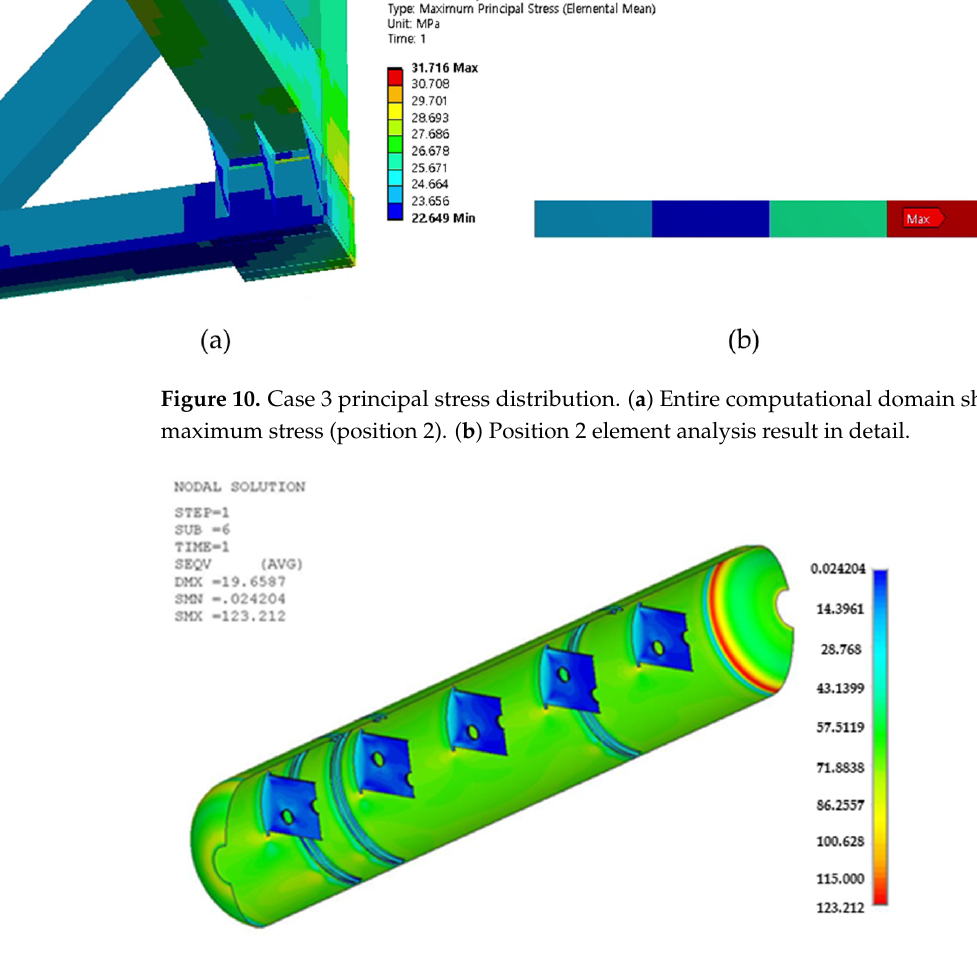
Figure 11. Case 4 principal stress contour map distribution results for low-cycle fatigue analysis.